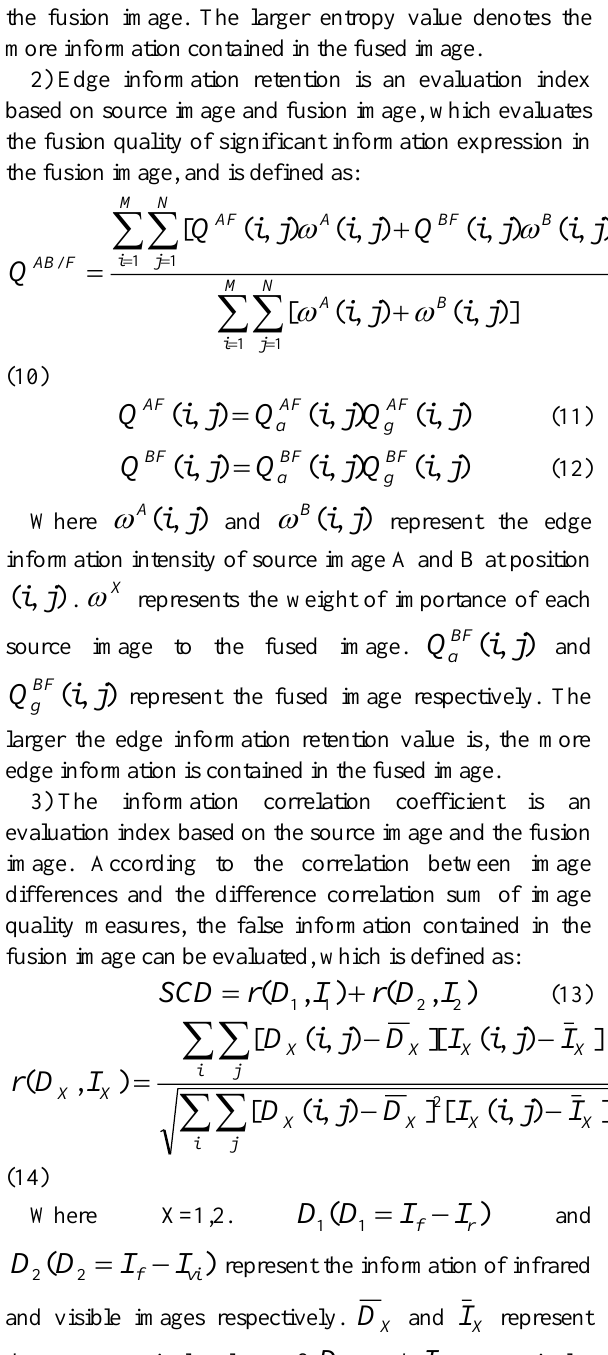
and visible images respectively. the average pixel values of